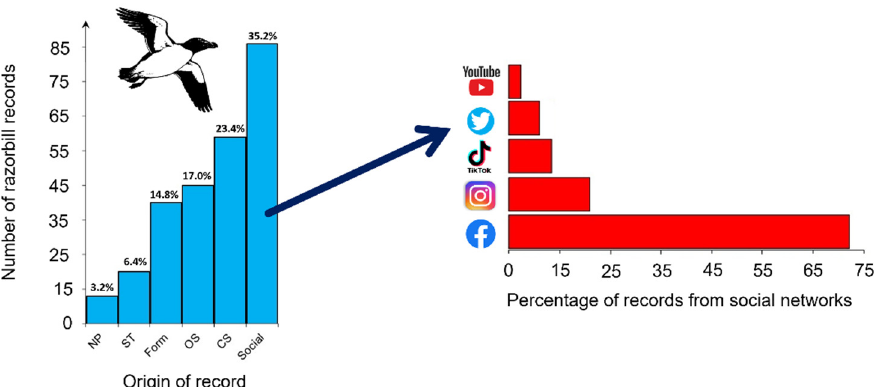
Figure 3. Typologies of collected records and percentage of records from different social networks and websites of video and photo sharing. Typologies of collected records were as follows: NP = newspapers; ST = stakeholders, i.e., organizations/associations operating along the coast or at sea; Form = questionnaire (Supplementary File S1); OS = ornithological survey; CS = data from citizen science platforms; Social = social network or another website of video/photo sharing.